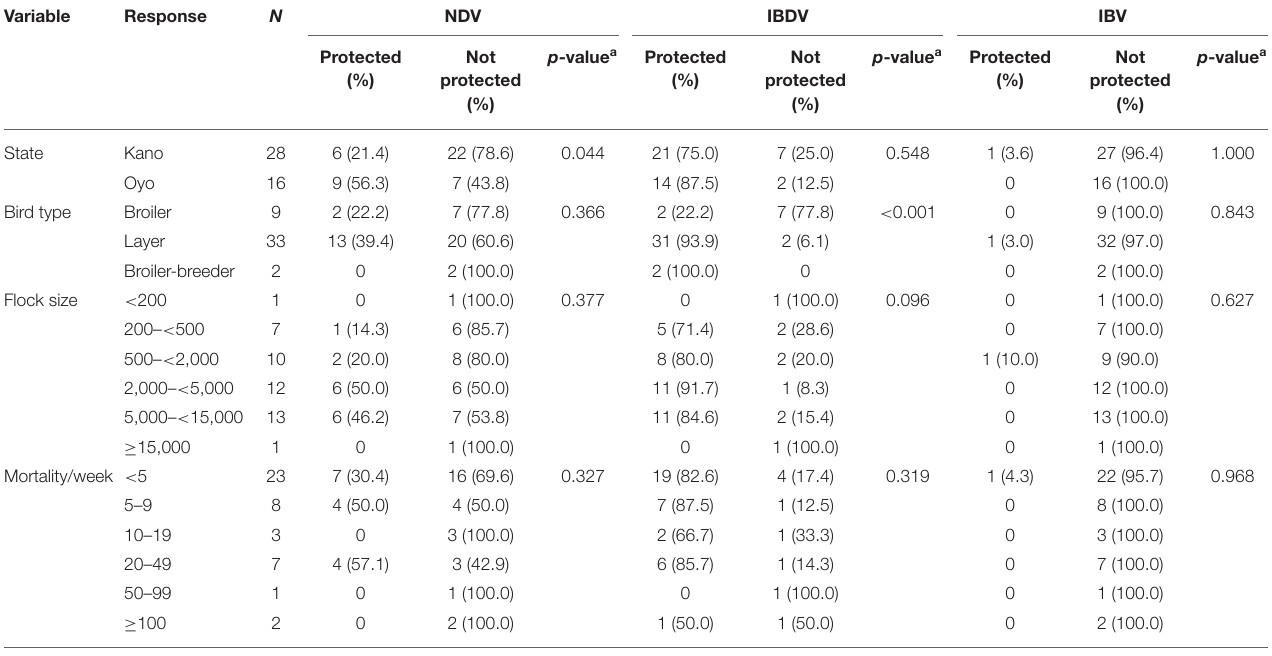
TABLE 3 | Descriptive analysis of study flocks, evaluating associations between select flock variables and flock-level protection against NDV, IBDV, and IBV. Variable